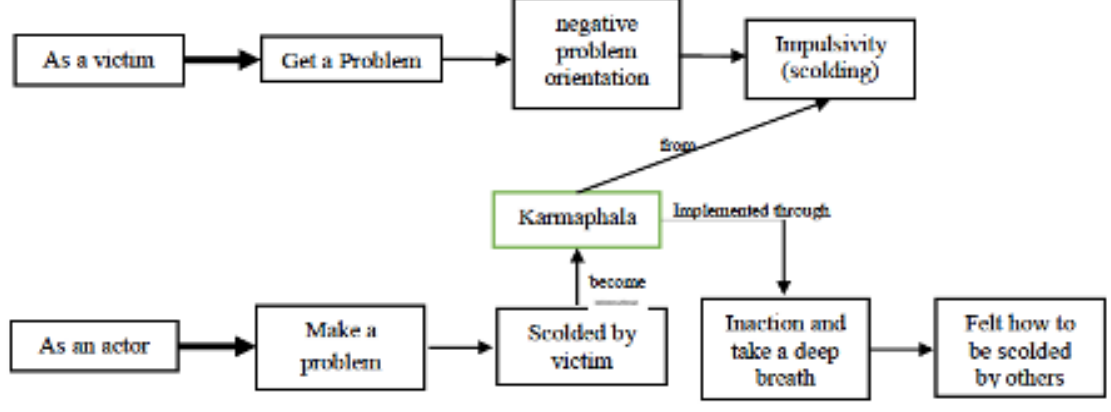
Fig. 2 Implementation process of Karmaphala value in First Informant's